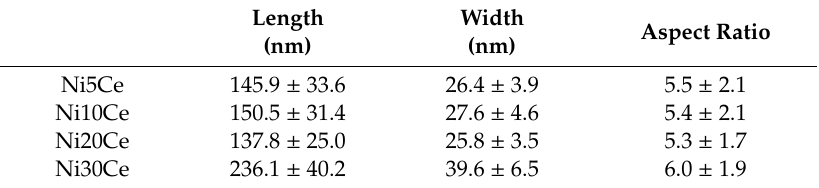
Table 3. Average values with standard deviation of length, width and aspect ratio of ceria